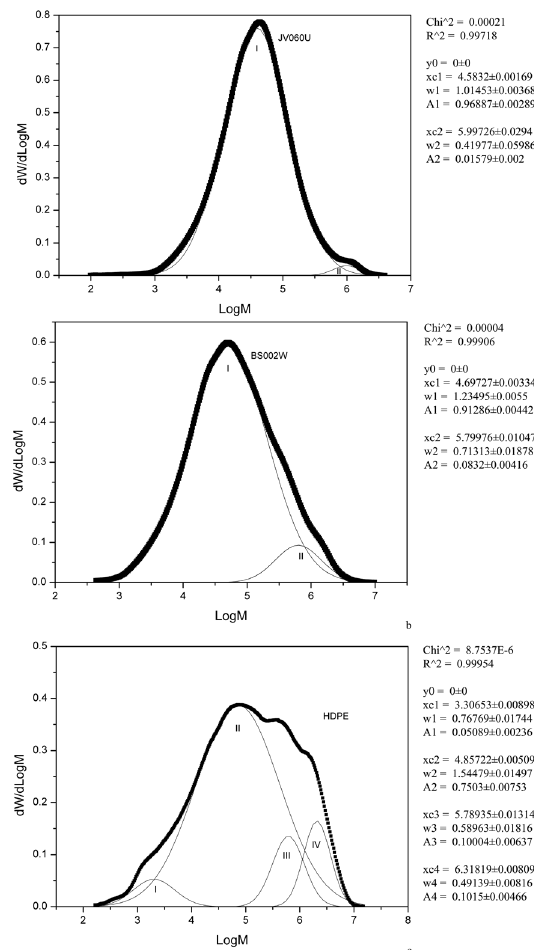
Figure 5. Decovolution of the molecular weight distribution: a) JV060U, b) BS002W, c) laboratory